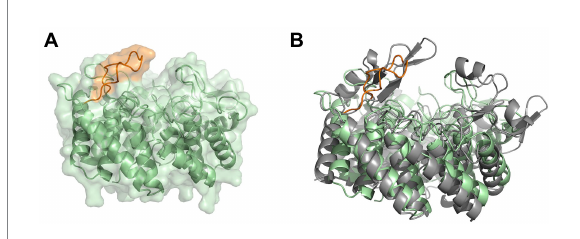
FIGURE 7 The modeled cyclase domain (residues 549–899) of SgbL from Streptomyces globisporus sp. NRRL B-2293. (A) AlphaFold2 model of the cyclase domain of the class IV modification enzyme SgbL. (B) Superimposition of the MadC crystal structure and the AlphaFold2 model of the cyclase domain of SgbL. MadC is colored in light